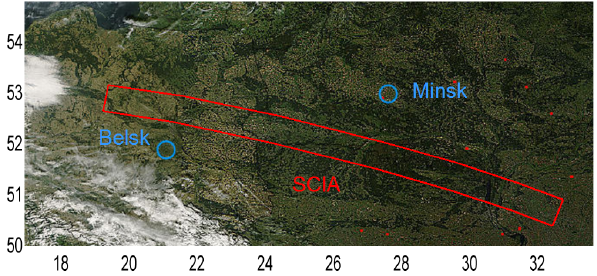
Fig. 7 MODIS RGB image over Eastern Europe on September 17, 2006. On this day, the sky was almost cloud-free and very low AOD (below 0.1 in the UV) were measured by an AERONET station in Minsk (marked with a blue circle). The red lines indicate the location of two west-east scanning sequences of the SCIAMACHY instrument on that day. Red dots in the figure indicate MODIS fire counts, but they are ignored here. The observed Ring effect, O 4 and O 2 absorption, as well as the normalised radiances for these measurements are shown in Figs. 8 and 9.